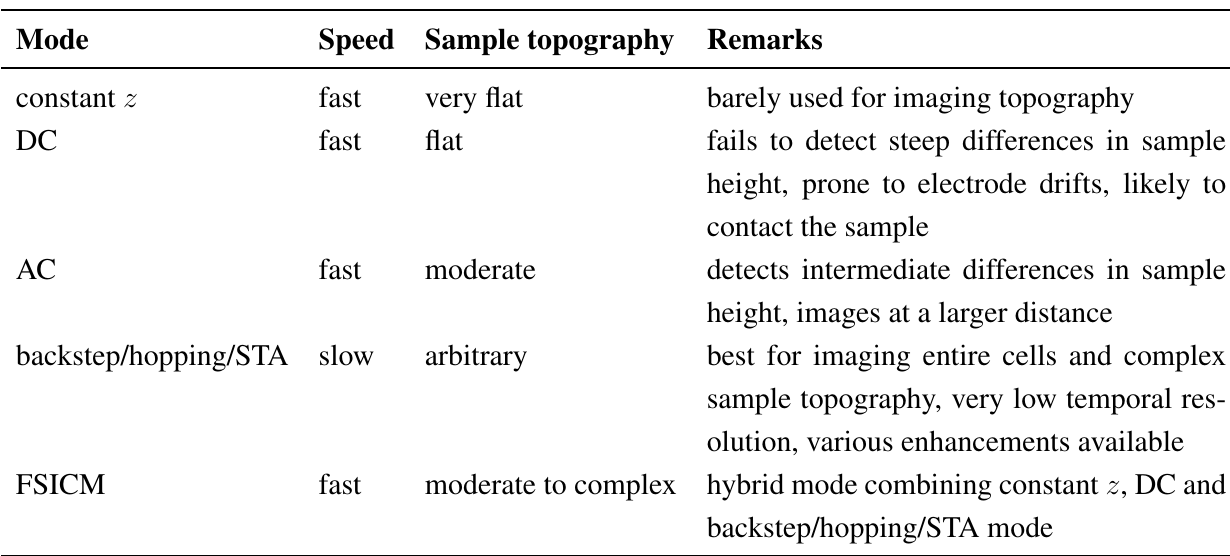
Table 1. Properties of various SICM imaging